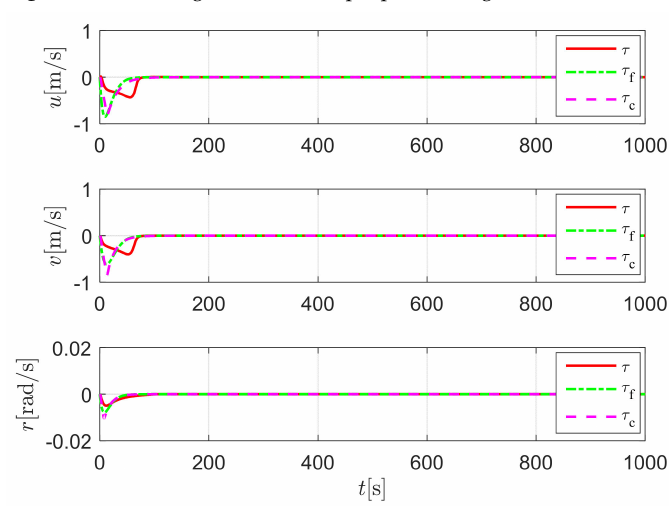
Figure 5. The change curves of ship’s positioning in Case 1.